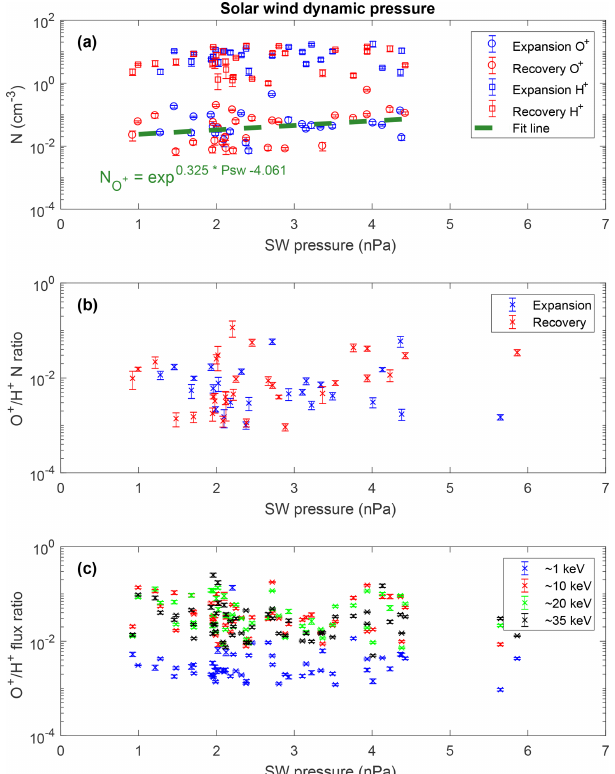
Figure 6. The relationship between the energetic O + at the duskside magnetopause and IMF B z during intense substorms. The format is the same as that of Fig. 4.